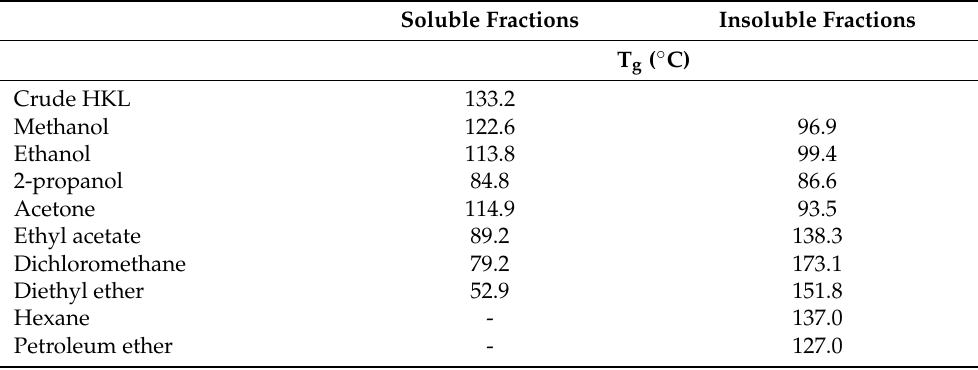
Table 5. Glass transition temperature of lignin fractions from hardwood kraft